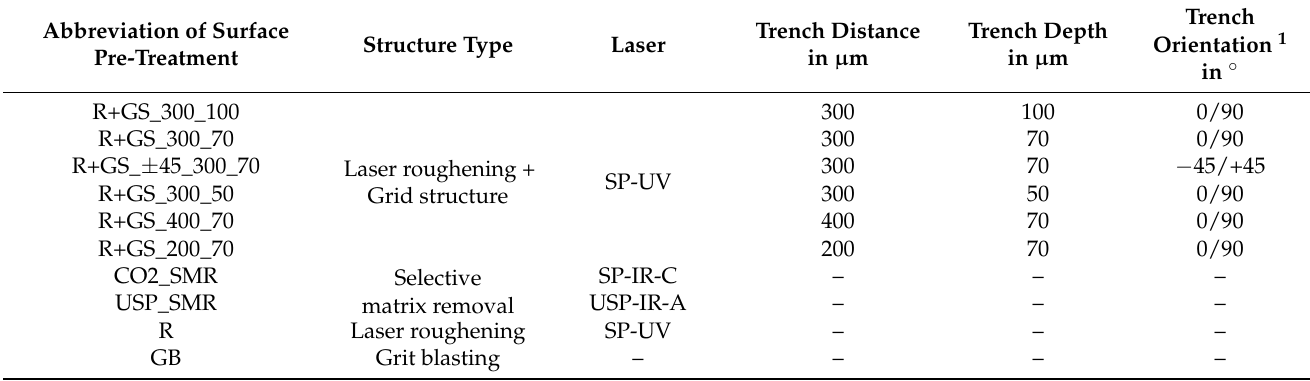
Table 3. Overview of examined surface